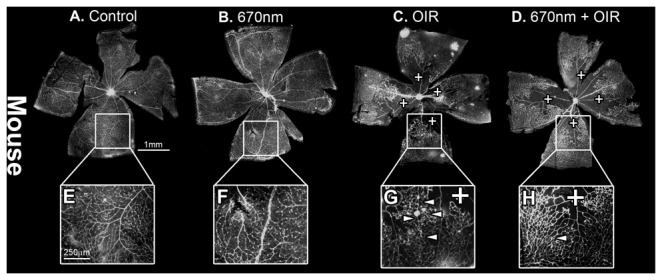
P17 c57BL/6J mice retinal wholemounts stained with lectin.(A,E) Control and (B,F) 670nm alone mice retina showed no observable difference in peripheral retinal vasculature, while (C,G) OIR alone showed increaed vaso-obliteration (indicated by +) and neovascularisation (indicated by arrowheads). There was also an observable vascular organisational difffernce in the OIR exposed retina (G). (D, H) 670nm+OIR, showed amelioration of neovascularisation, vaso-obliteration and a more uniform vascular patterning. P – postnatal day, OIR - Oxygen induced retinopathy. Scale A - D = 1mm, E -H = 200µm, I. Magnification of images E-H are 4x original images.